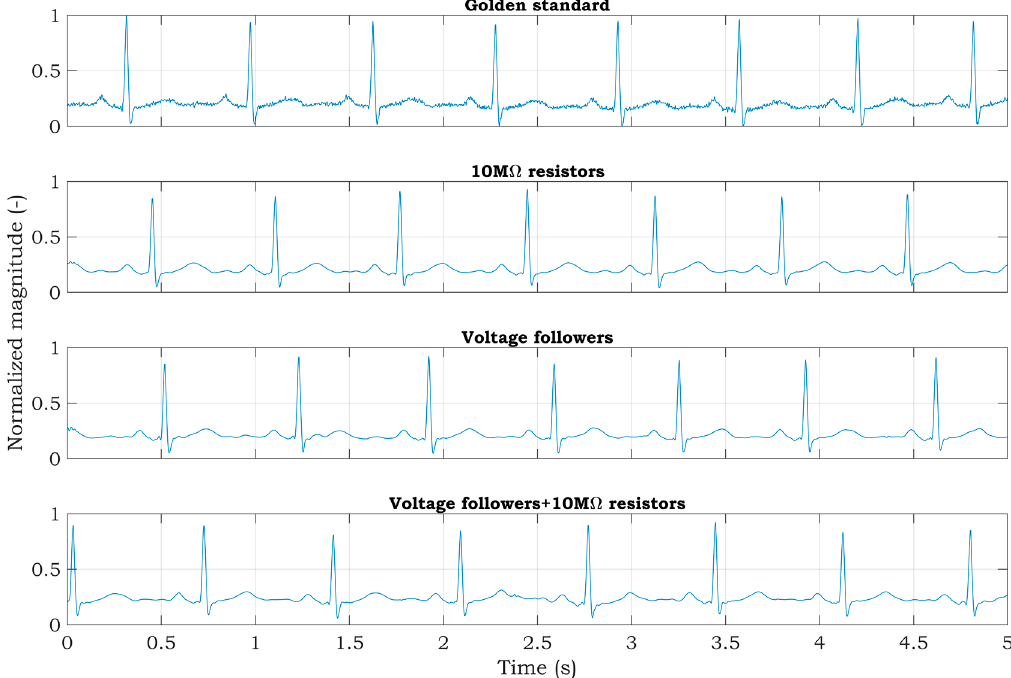
Figure 14. Wavelet filtration of ECG signals measured from a living subject.